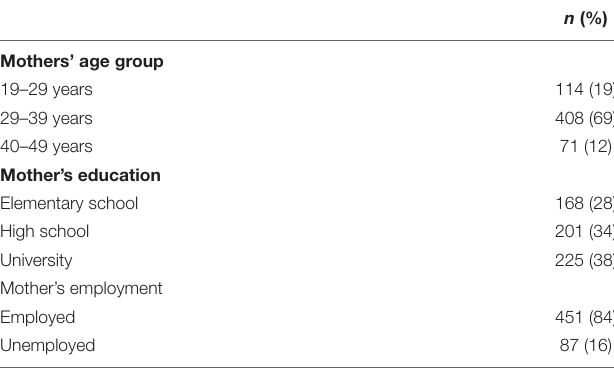
TABLE 1 | Mothers’ distribution, according to age, education, and employment ( N =